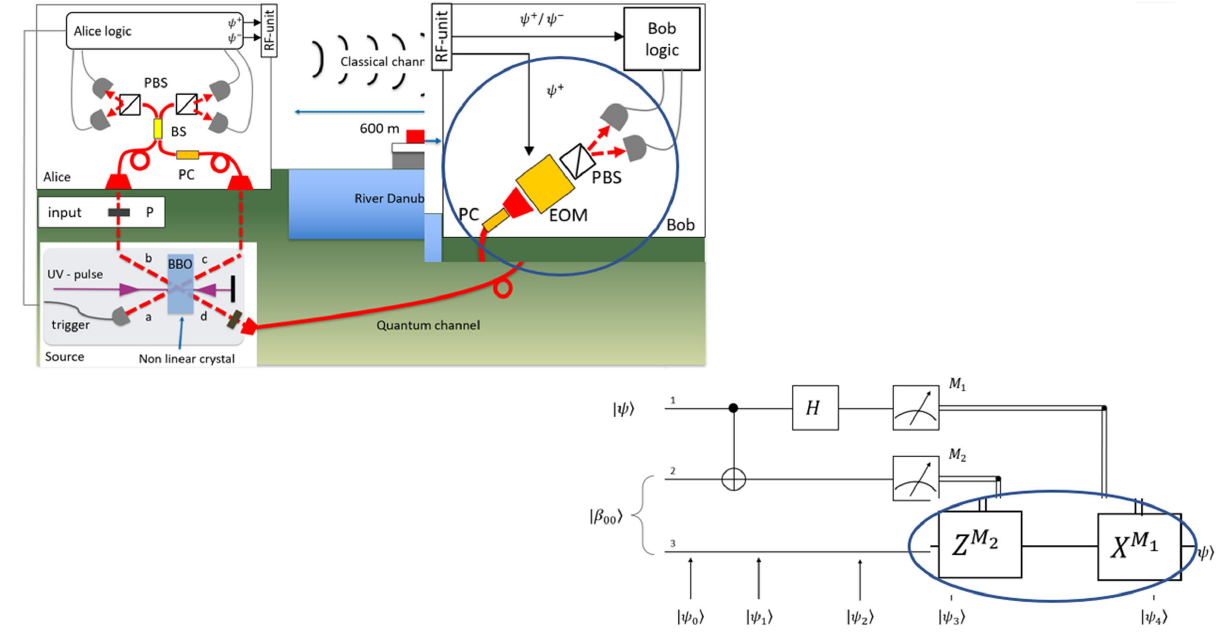
FIG. 16. Comparison between experimental and computational recovery of the input state.